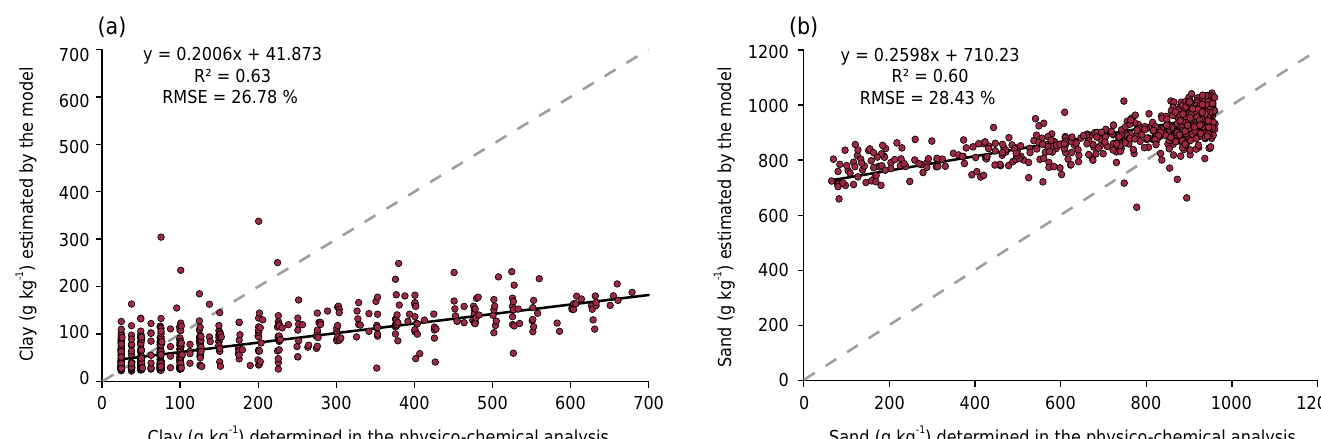
Figure 6. Coefficient of determination of the soil properties of Area 2 estimated by the equations generated from the reflectance data of the Landsat 7 sensor from Area 1. The dotted line represents the ideal